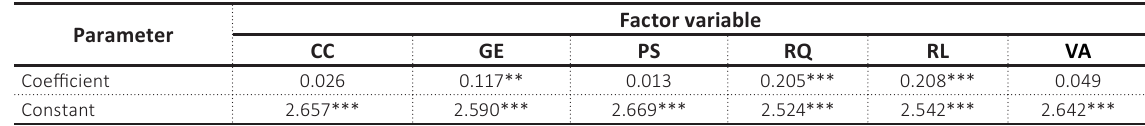
Source: Authors’ results.